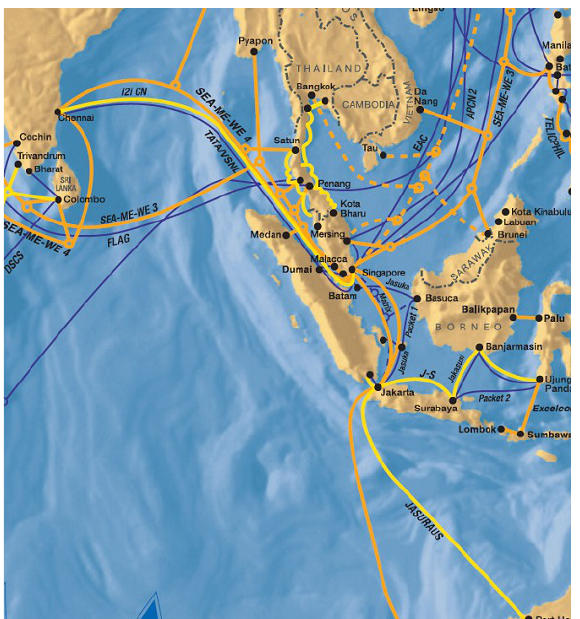
Fig. 4. Sea cables available for communications to/from Indone- sia. Source: Alcatel-Lucent, Worldmap of optical fibre submarine networks, 2007.